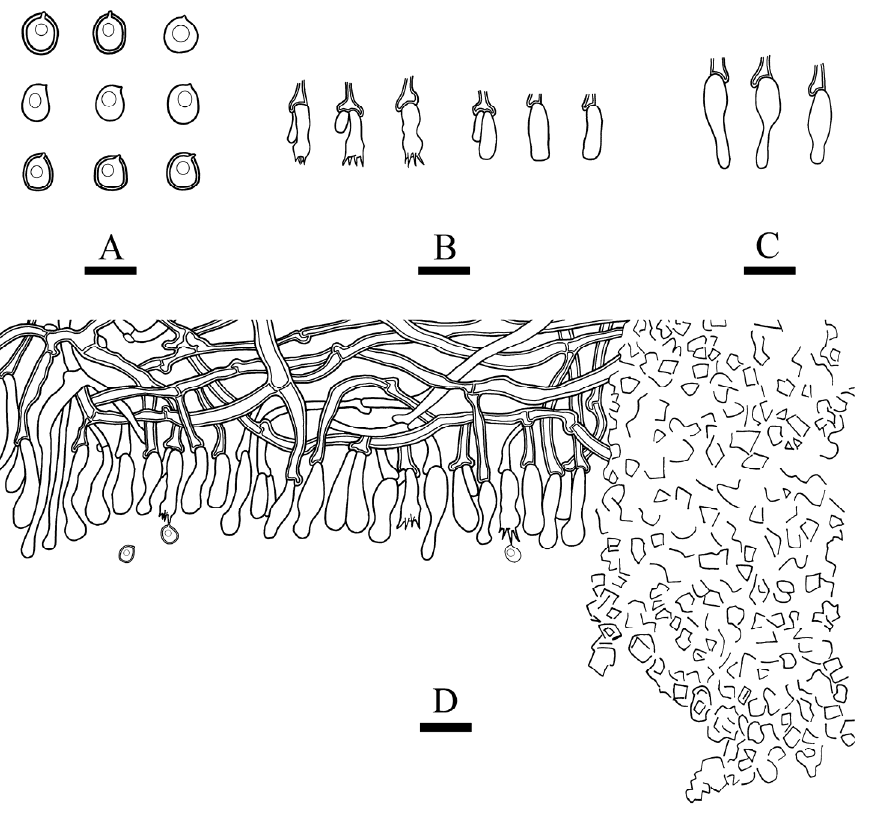
Figure 11. Microscopic structures of Xylodon sinensis (holotype) ( A ): basidiospores ( B ), basidia and basidioles ( C ), and fusiform cystidia ( D ). A section of hymenium. Bars: a = 5 µm, b–d = 10